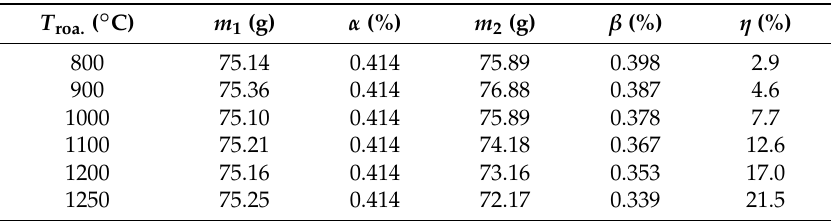
Table 2. Masses and vanadium contents of the samples before and after roasting and vanadium loss. Roasting time: 2 h, particle size: − 74 µ m of particle size, atmosphere: air.